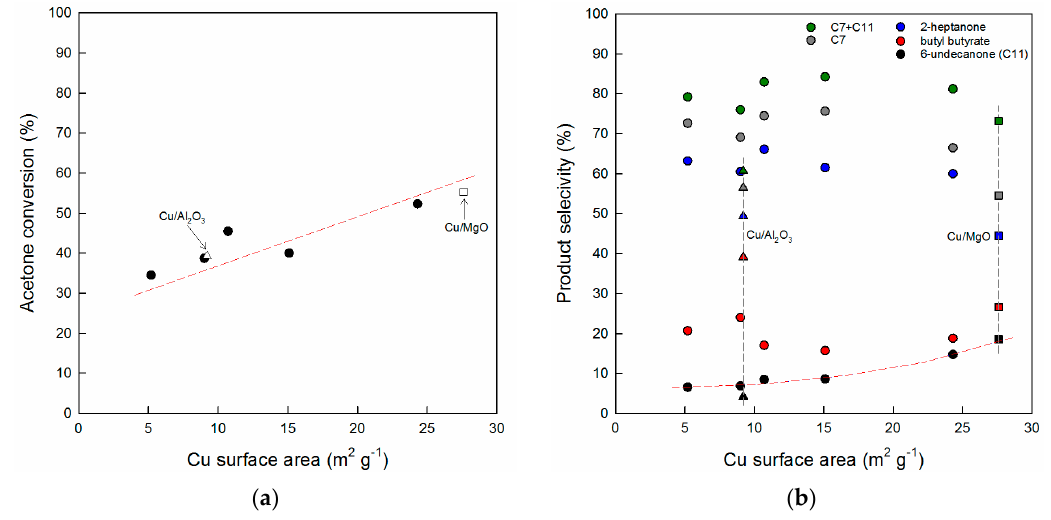
Figure 5. ( a ) Acetone conversion and ( b ) product selectivities plotted against the specific Cu surface area ( S Cu ) of Cu/ x CeZr (circles), Cu/MgO (squares), and Cu/Al 2 O 3 (triangles) catalysts. C7 includes 3-hepten-2-one, 2-heptanone, and 2-heptanol.